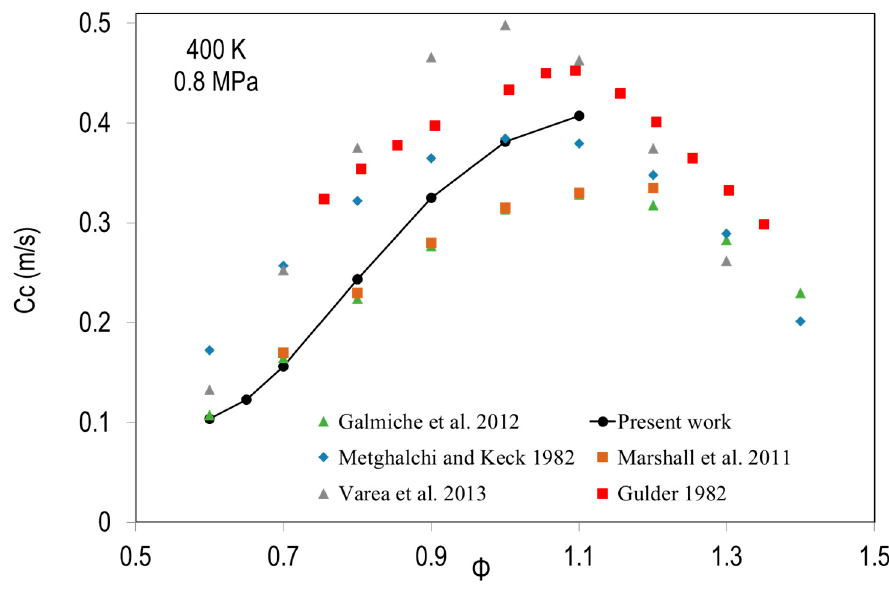
Figure 7. Comparison of the burning velocity of iso-octane versus the equivalence ratio, for 0.8 MPa and 400 K of the initial conditions.